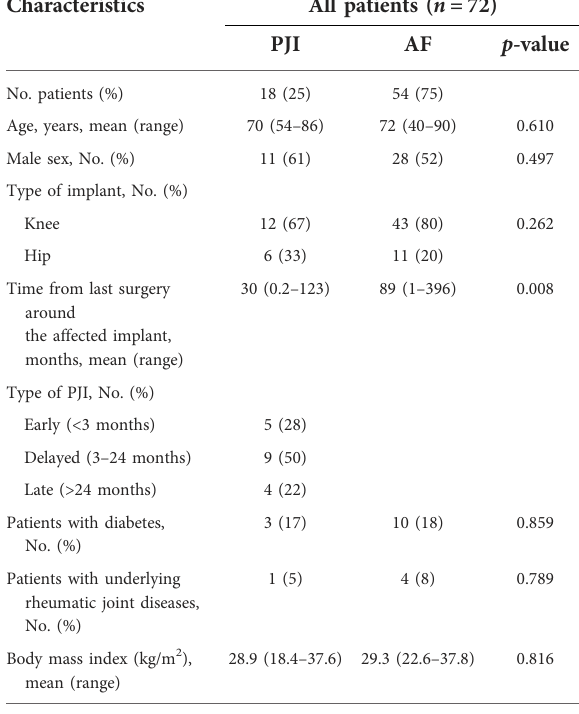
TABLE 1 Demographic data and infection characteristics of 72